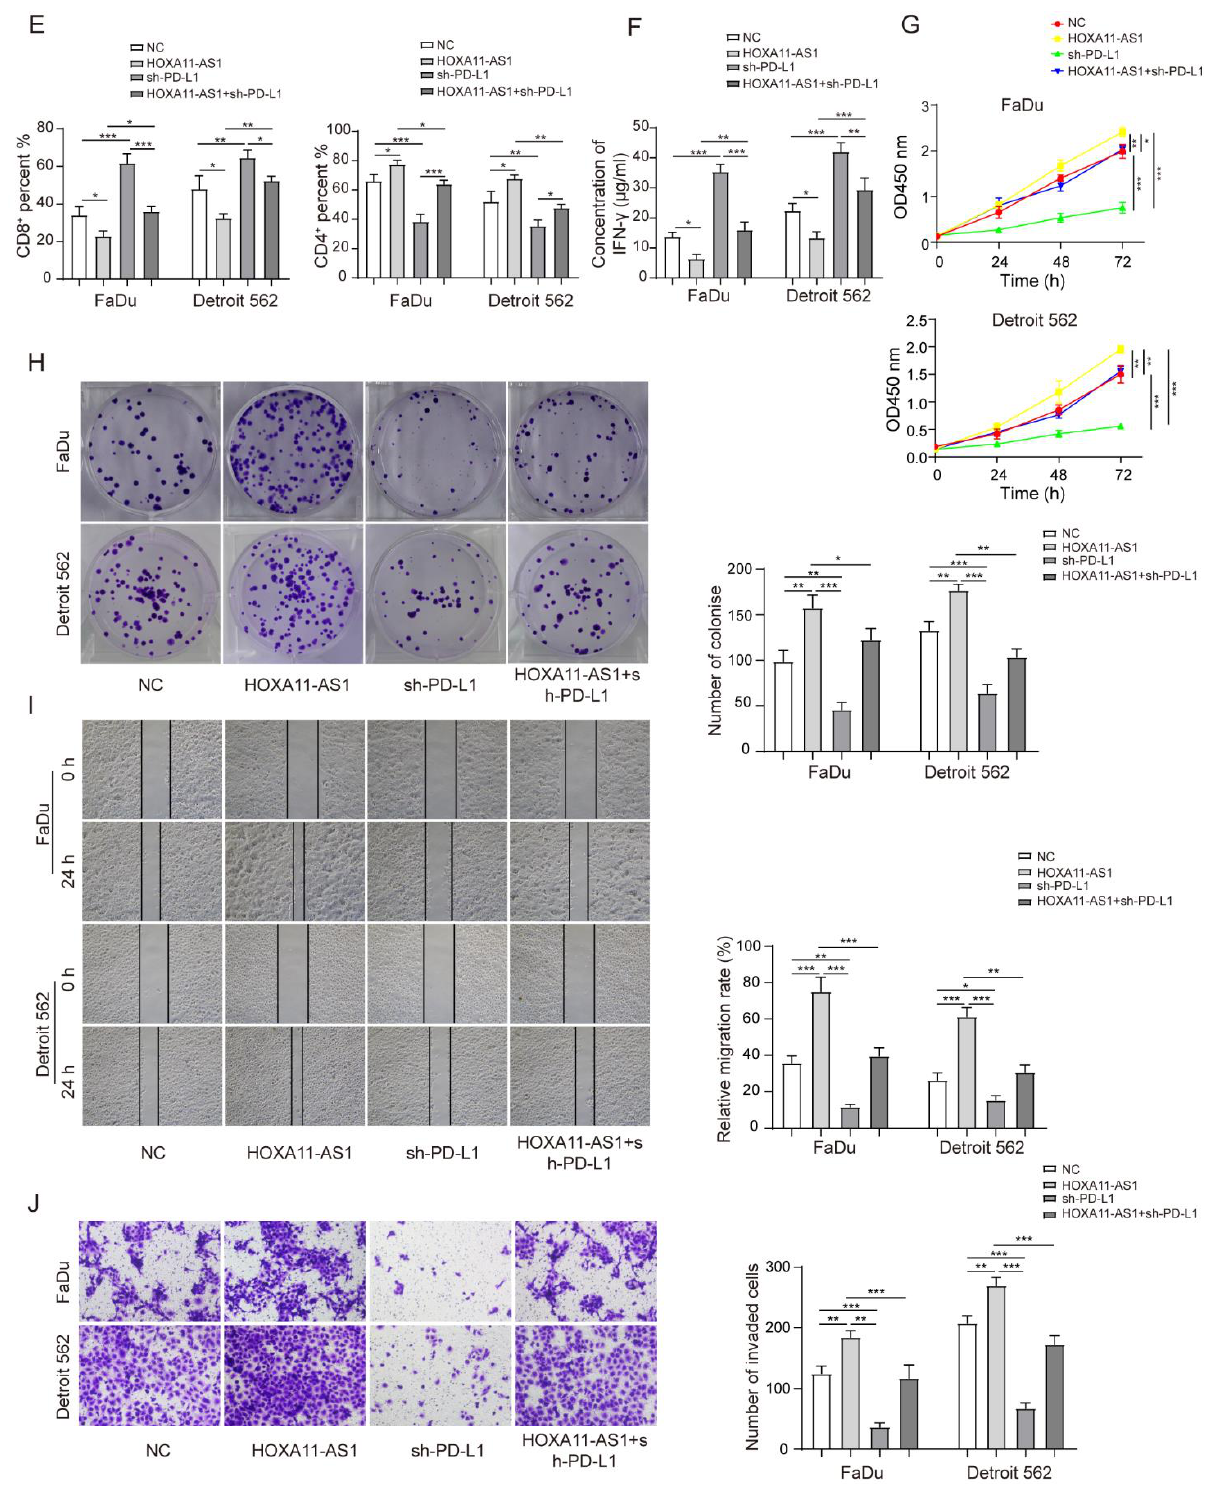
Figure 5. HOXA11-AS1 promoted PD-L1 expression by upregulating FOSL1 levels through PTBP1, thereby facilitating immune escape, growth, and metastasis of HSCC cells. FaDu and Detroit cells were transfected with pcDNA3.1-HOXA11-AS1 (HOXA11-AS1), pcDNA3.1-PTBP1 (PTBP1), sh-PTBP1, sh-PD-L1, or a combination of HOXA11-AS1 + sh-PTBP1 and HOXA11-AS1 + sh-PD-L1: ( A ) HOXA11-AS1, FOSL1, and PD-L1 levels were measured in FaDu and Detroit 562 cells treated with HOXA11-AS1 plasmid. ( B ) Relative expression of PTBP1, FOSL1, and PD-L1 was evaluated after overexpressing PTBP1. ( C ) Relative levels of PTBP1, FOSL1, and PD-L1 in HOXA11-AS1, shPTBP1, or HOXA11-AS1 + shPTBP1 groups. FaDu and Detroit cells were transfected with HOXA11-AS1,